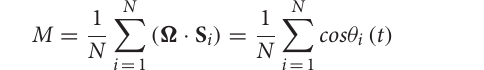
Frontiers in Earth Science |